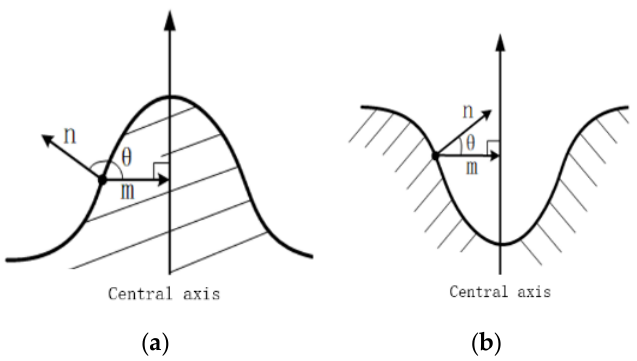
Figure 8. Profile analysis of positive and negative obstacles. ( a ) positive obstacle; ( b ) negative obstacle.